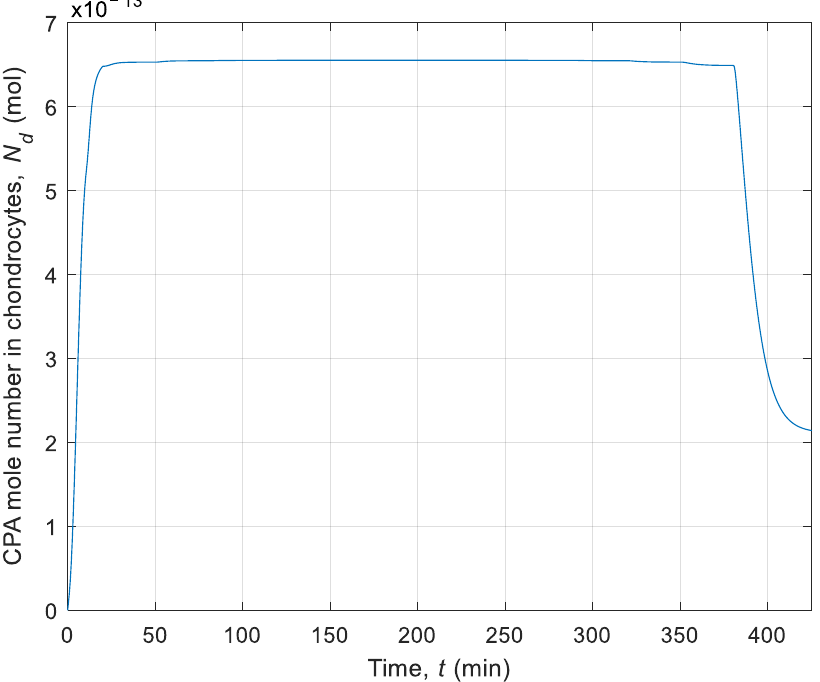
Figure 5. Distribution of the intracellular concentration after 10 s for transition from 22 ◦ C to − 5 ◦ C for: ( a ) C i